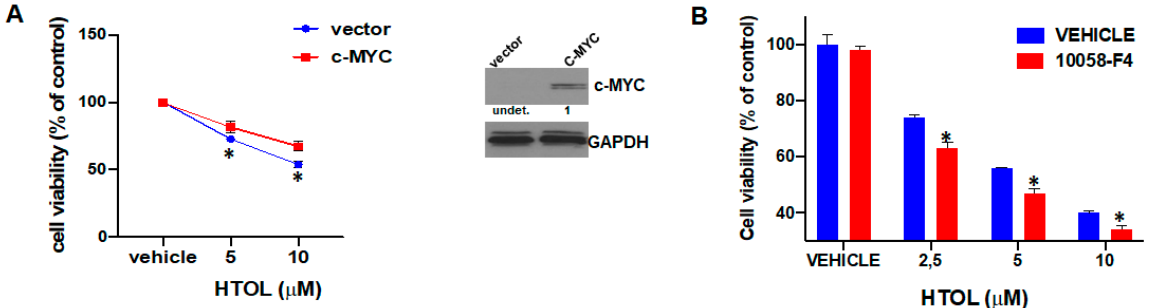
Figure 4. c-MYC affects MM cells’ responsiveness to HTOL. ( A ) Cell viability of U266 transduced with pCDH empty vector or pCDH-c-MYC as determined by CTG assay, 24 h after treatment with increasing doses of HTOL or vehicle (DMSO); * p < 0.05 as compared to empty-vector transfected cells. Right panel refers to WB analysis of c-MYC performed using lysates from U266 cells transduced with pCDH empty vector or pCDH–cMYC. ( B ) Cell viability as determined by CTG assay in NCI-H929 cells treated for 24 h with 10 μ M 10058-F4 in combination with HTOL or DMSO; * p < 0.05 as compared to vehicle-treated cells.